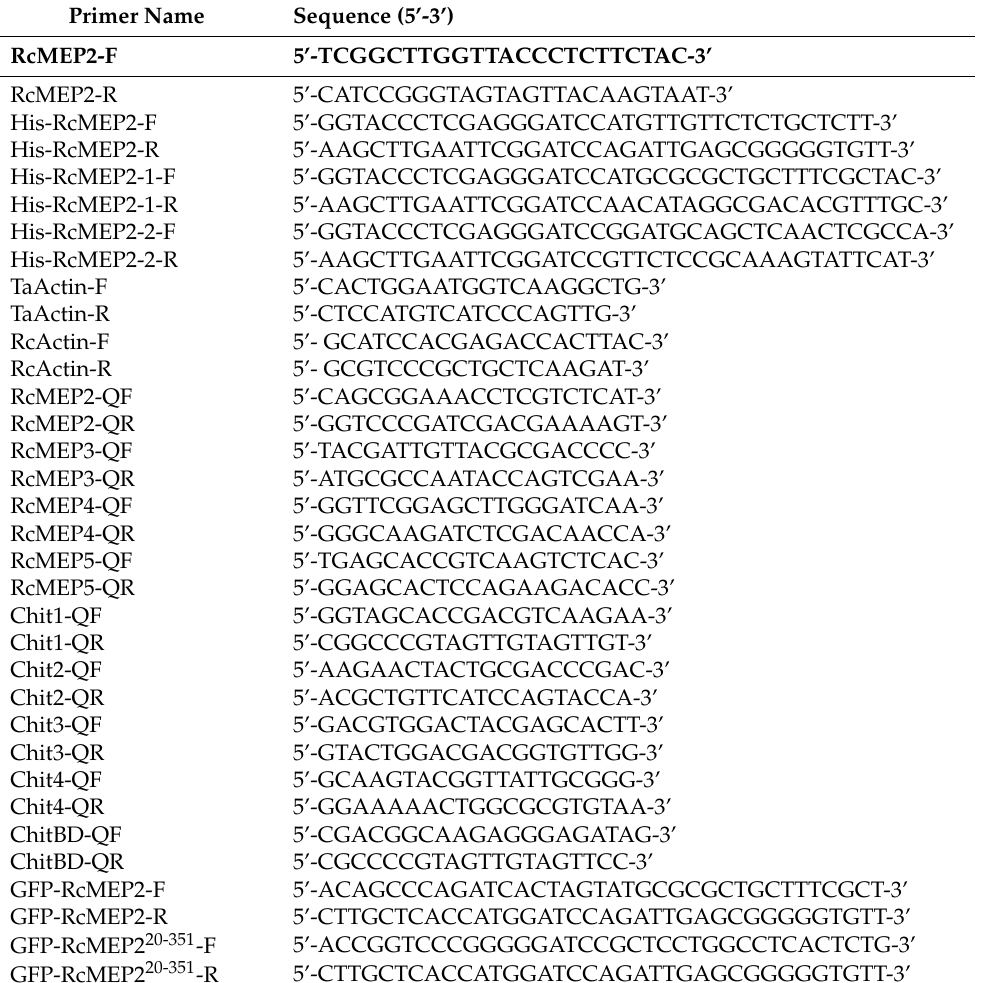
Table 1. Primers and their